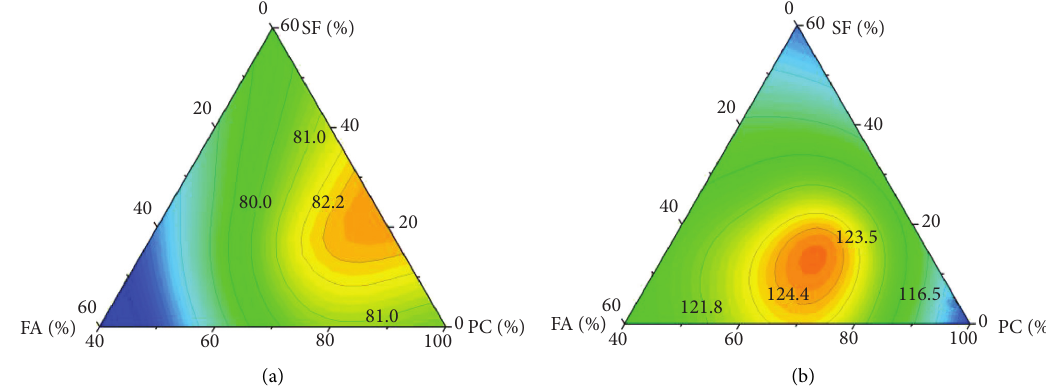
Figure 4: Effects of different cementitious composition on the strength of UHSC: (a) 3 days and (b) 28